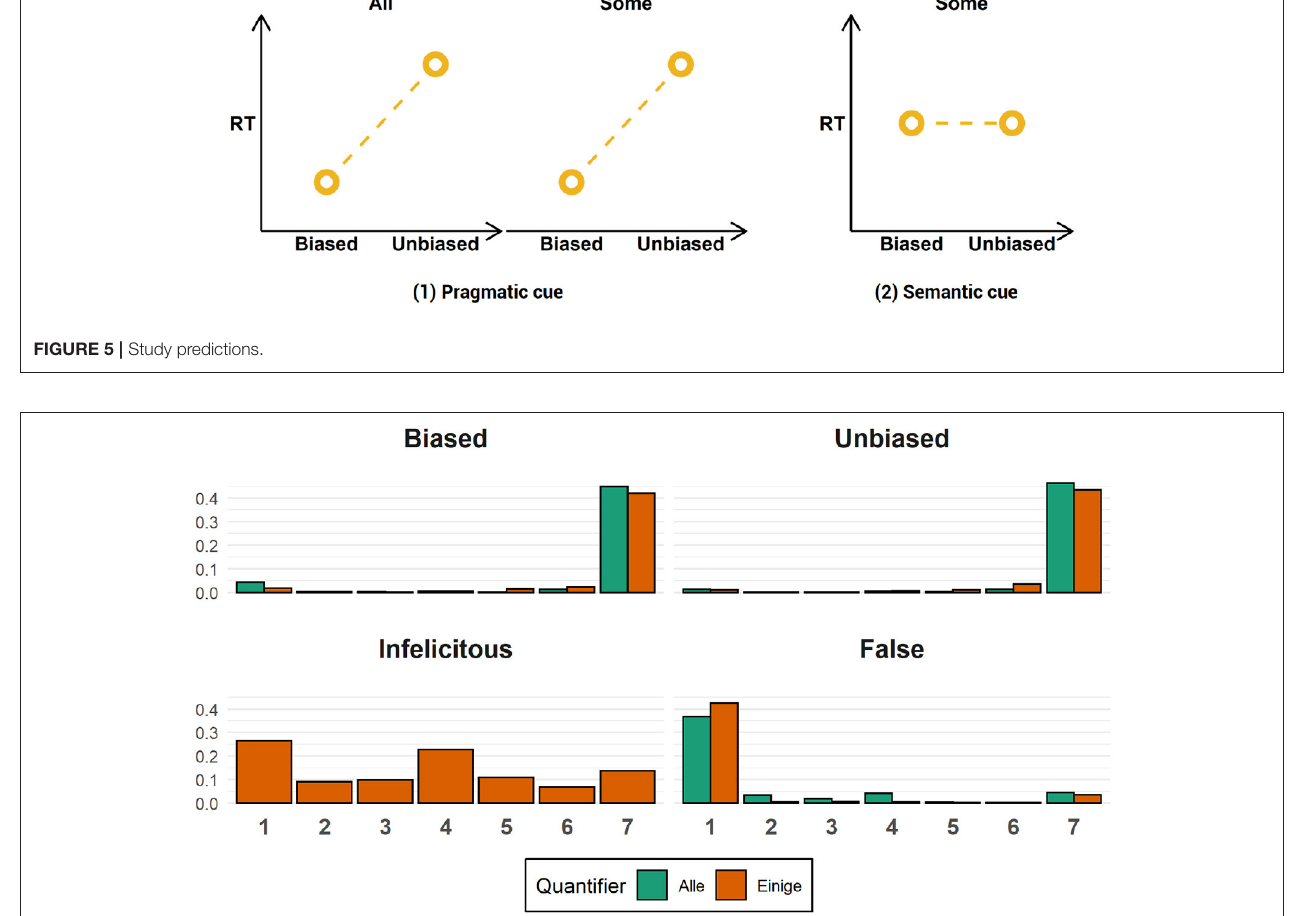
FIGURE 6 | Sentence ratings. Each panel shows the proportion of ratings for a given critical condition. Ratings for sentences containing the quantifier alle are shown in green, while ratings for sentences containing the quantifier einige are shown in